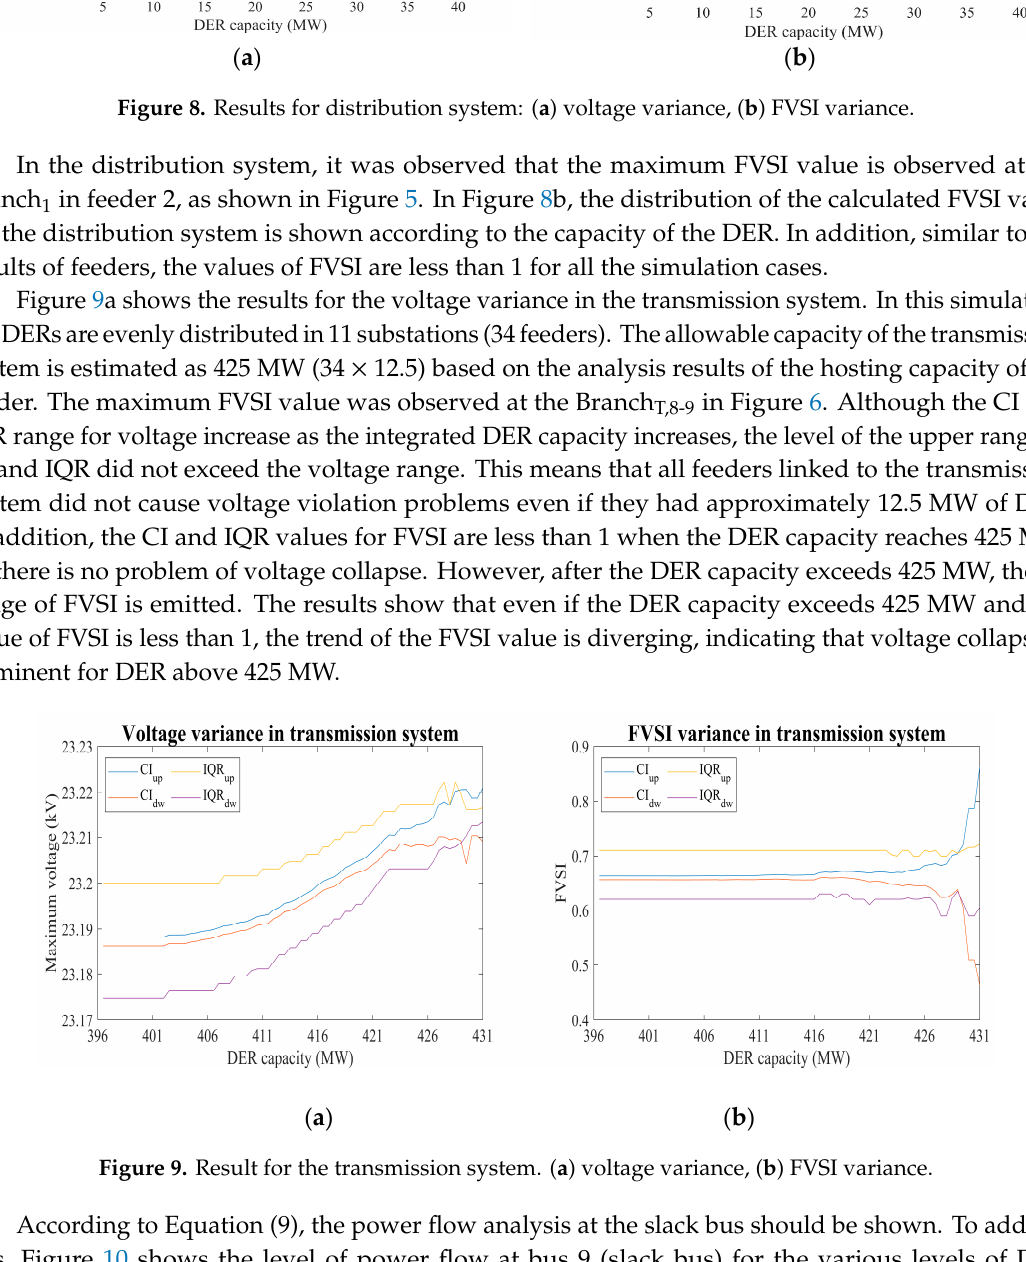
Figure 8. Results for distribution system: ( a ) voltage variance, ( b ) FVSI variance.